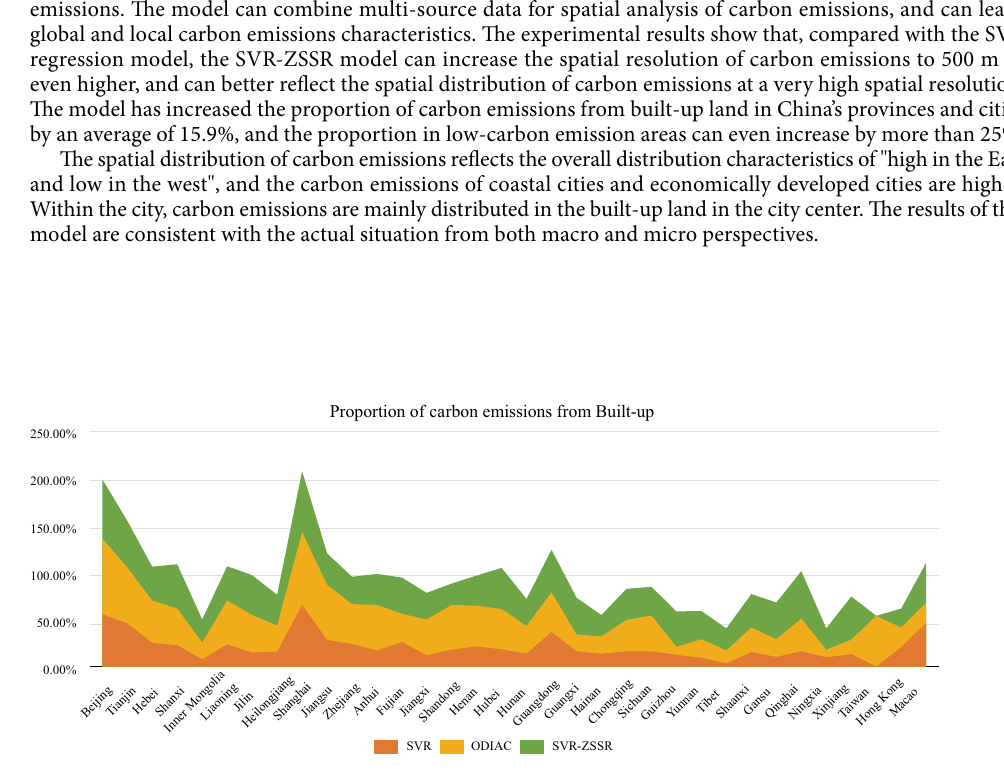
Figure 5. Comparison of SVR model and SVR-ZSSR model in the proportion of carbon emissions in built-up land in each